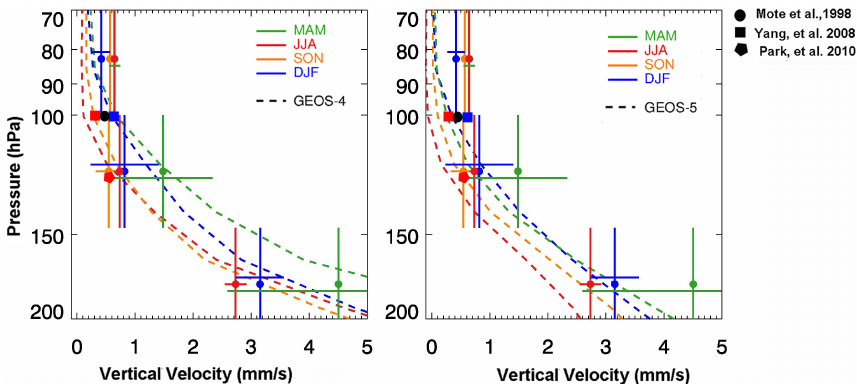
Fig. 13. Comparison of seasonal mean profiles of vertical velocity deduced from reconstructed MLS CO mixing ratios (solid circles with vertical and horizontal bars color coded by season: green, spring; red, summer; orange, autumn; blue, winter) and those for the assimilated meteorological fields, GEOS-4 (left), and GEOS-5 (right); the same color code is used for the seasons. The vertical bars show the pressure range of the two levels used to derive the vertical velocities from MLS CO. The horizontal error bars show one standard deviation of the seasonal mean vertical velocities, and are offset slightly for clarity. At ∼ 180hPa the derived vertical velocity for autumn overlaps that for summer. The black dot shows the tropical annual mean vertical velocity deduced from MLS H 2 O (Mote et al., 1998). The squares show the seasonal mean vertical velocity deduced from radiative heating rates (Yang et al., 2008). The pentagon shows the vertical velocity deduced from CO 2 in summer (Park et al., 2010).